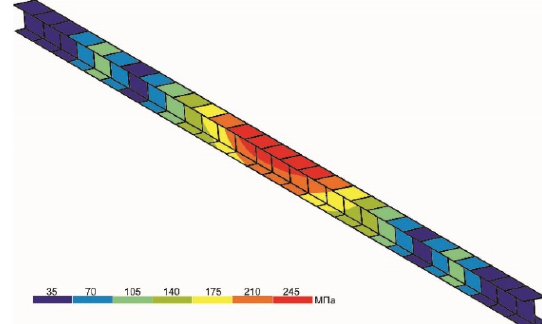
Figure 4. Equivalent stress distribution field, stretching, displacement of the axis of an adjacent automatic coupling 0.1 m higher than the considered, MPa